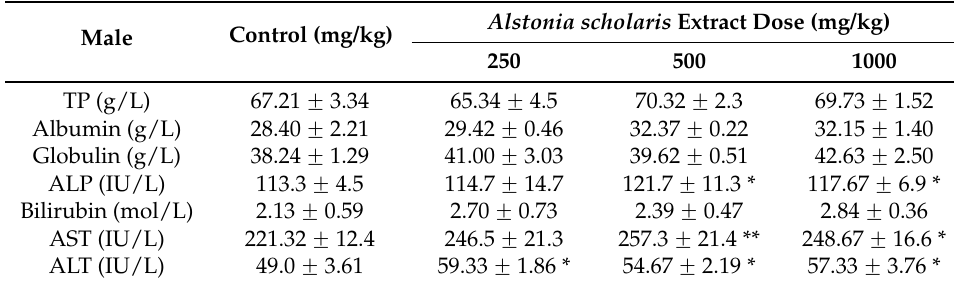
Table 6. Biochemical parameters in the serum of male rats orally treated with the methanolic extract of the bark of Alstonia scholaris . Results were expressed as the mean ˘ S.E.M., n = 5. Male